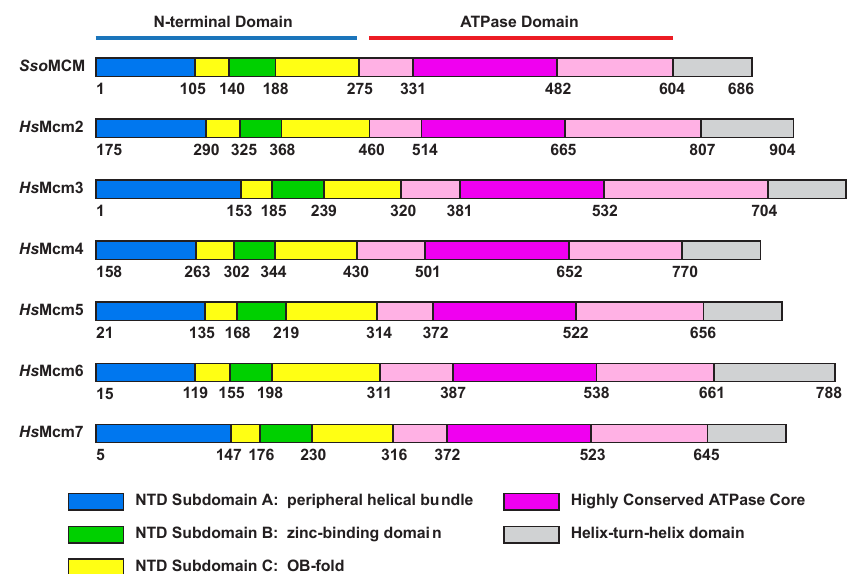
Figure 2. Subdomain architecture of MCM proteins. Subdomains are as assigned previously [44]. ( A ) Three perpendicular views of the subdomain architecture of Sso MCM within the MCM–ssDNA– MgADP-BeF 3 class 1 structure. The “side” view is perpendicular to the central channel with the N-terminal tier on top and the ATPase tier on the bottom. The “bottom” view is parallel to the central channel from the ATPase tier side. The “top” view is parallel to the central channel from the N-terminal tier side. The model obtained from the merged particle set is illustrated. From the N-terminal tier, the peripheral helical bundle subdomain is in blue, the OB-fold subdomain in yellow, and the Zn-binding subdomain in green. The ATPase tier is in pink and magenta with the core contiguous 152-amino-acid segment (see Figure S5) in magenta and other portions in pink. The bound strand of DNA is in cyan stick representation. ( B ) Three perpendicular views of the subdomain architecture of the human CMG–ssDNA structure (PDB 6XTX [22]) emphasizing Mcm2-7. Colors are similar to ( A ) with the peripheral helical bundle subdomain in blue, the OB-fold subdomain in yellow, and the Zn-binding subdomain in green. Subdomains are as assigned previously [44]. The ATPase tier is in pink and magenta with the core contiguous 152-amino-acid segment in magenta. The bound strand of DNA is in cyan stick representation. Cdc45 and the tetrameric GINS complex are at the periphery and colored wheat, light pink, light blue, light green, and yellow–orange. ( C ) Block diagrams indicating the amino acid sequence boundaries of each subdomain for the proteins depicted in ( A , B ). ( A , B ) were prepared with Pymol